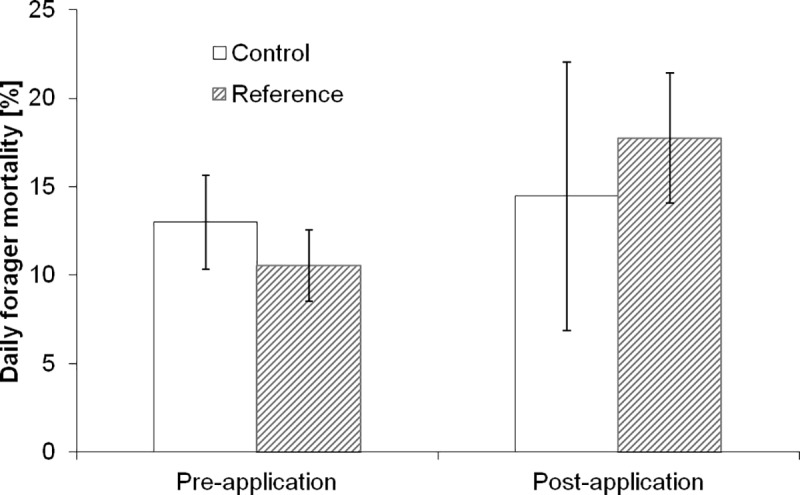
Daily forager mortality in the tunnel before and after the application.Error bars indicate one standard deviation.